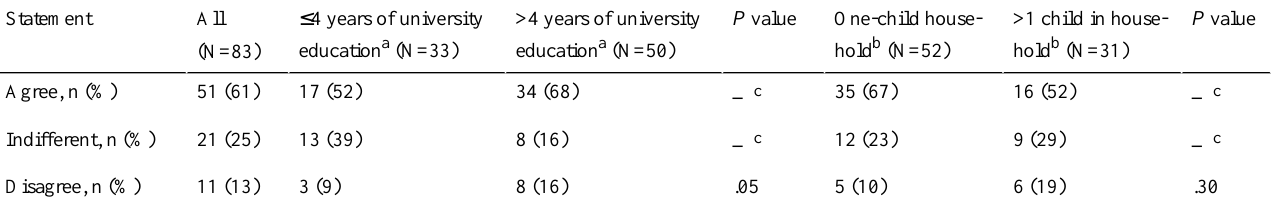
Table 4. Perceived acquisition of new knowledge among parents in the intervention group according to educational level and number of children in the household, through response to the prompt "Think of the Food4toddlers website in total, and indicate how strongly do you agree/disagree with the statement I learned something new?